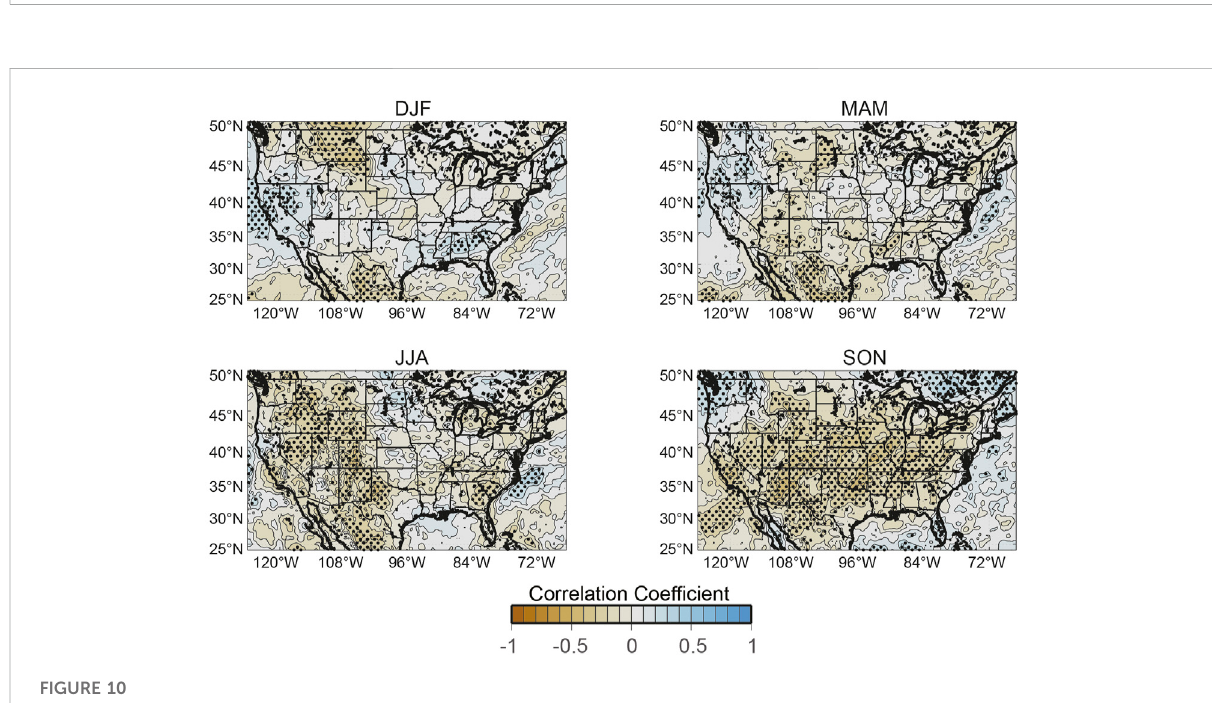
phase and SCUSA temperature, with the relationship statistically signi fi cant across large swaths of the SCUSA in winter, spring, and summer and in the Gulf of Mexico in winter and spring months (Figure 11). Anomalously warm Paci fi c